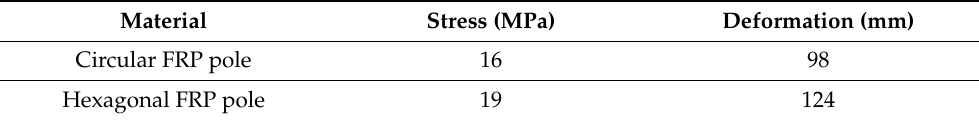
Table 6. Stress and deformation of FRP